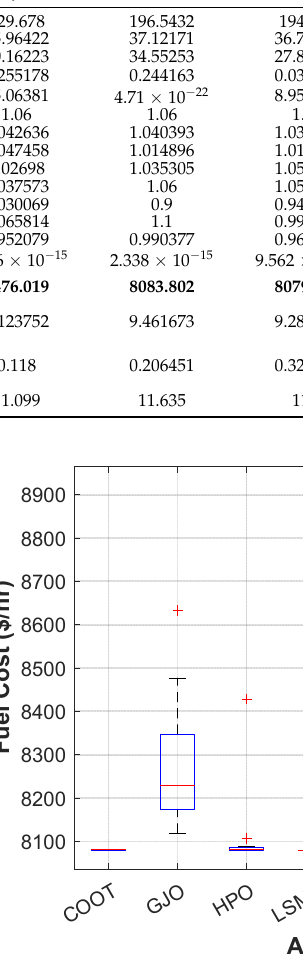
Figure 5. Boxplot of POA and other compared algorithms for case 1 in a standard IEEE 14-bus test system.